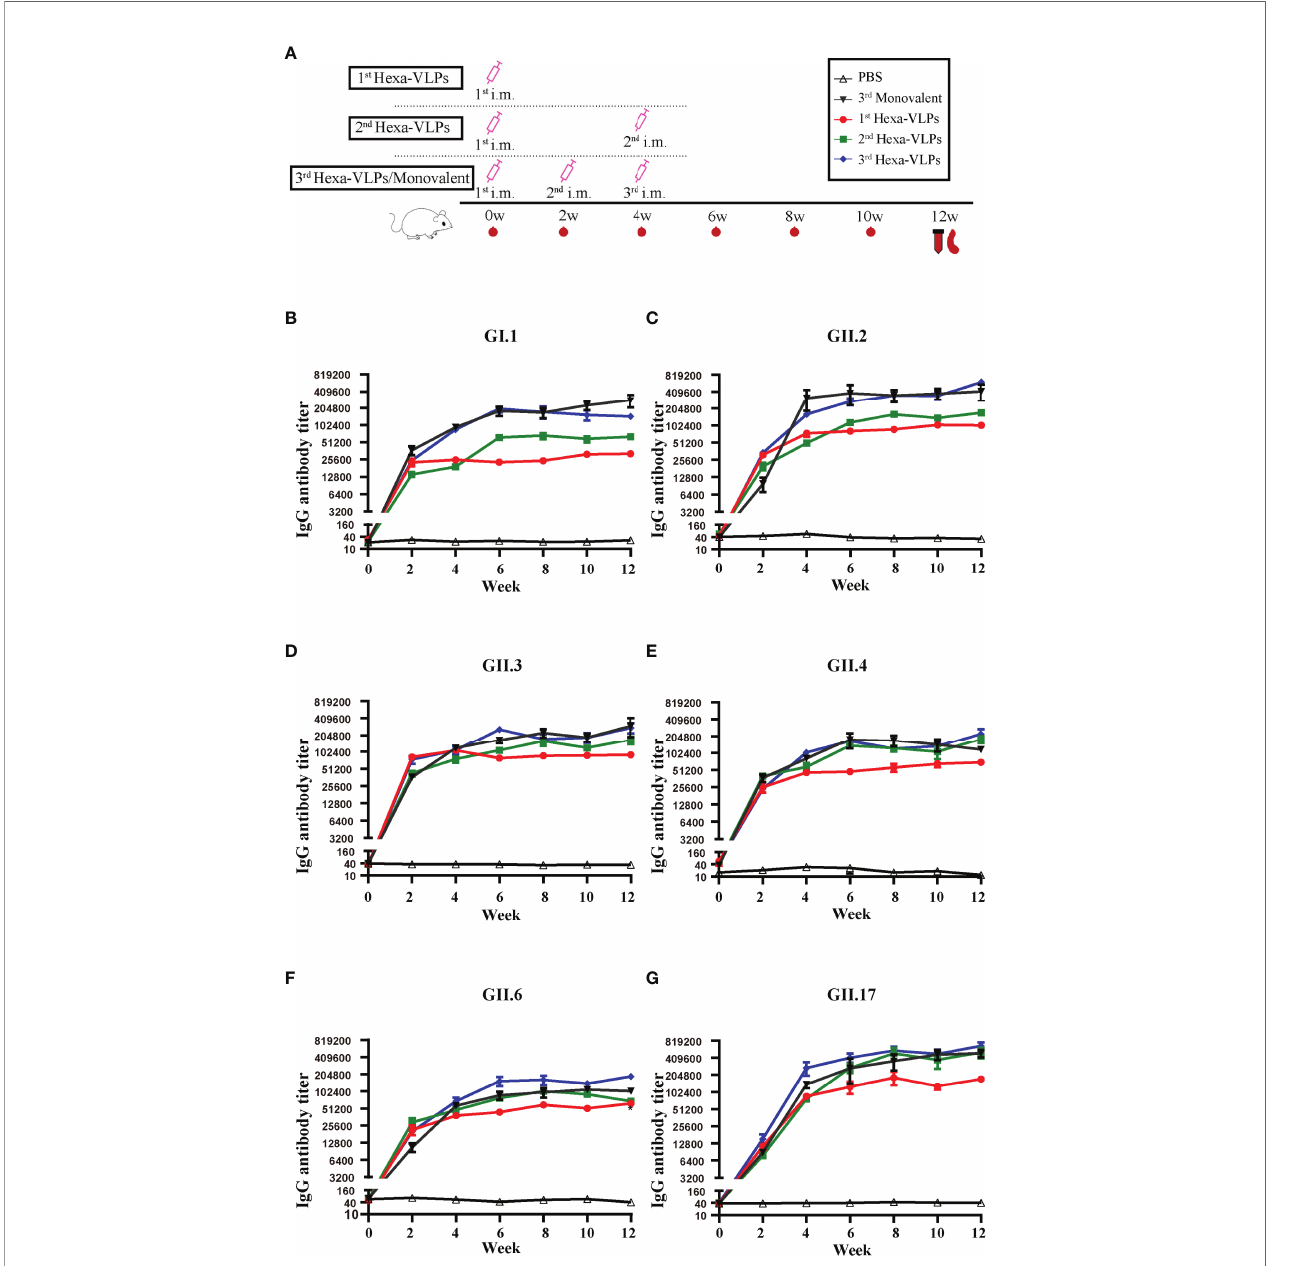
FIGURE 4 | Total IgG responses of different immune regimens. (A) Immunization schemes of mice. BALB/c mice (n = 5 per group) were immunized IM. The control group, six monovalent groups and 3 rd Hexa-VLPs group were immunized at day 0, day 14 and day 28 with PBS, 5 µg GI.1/GII.2/GII.3/GII.4/GII.6/GII.17 or 30 µg Hexa-VLPs (each VLPs accounts for 5 µg), respectively. For the 1 st Hexa-VLPs group, 30 µg Hexa-VLPs were inoculated at day 0, while the 2 nd Hexa-VLPs group at day 0 and day 28. All VLPs were adjuvanted with equal volume of 500 µg alum. Blood samples were collected 2 days before each immunization and every 2 weeks after the last inoculation. Mice were euthanized at 12 w for spleen isolation. Binding IgG against (B) GI.1, (C) GII.2, (D) GII.3, (E) GII.4, (F) GII.6 and (G) GII.17 VLPs were detected using ELISA. Sera dilution and endpoint titer calculation were consistent with Figure 2 . All data were shown as means ± SEM. Statistical differences at 4 w, 8 w, 12 w were analyzed using one-way ANOVA test with Tukey correction for multiple